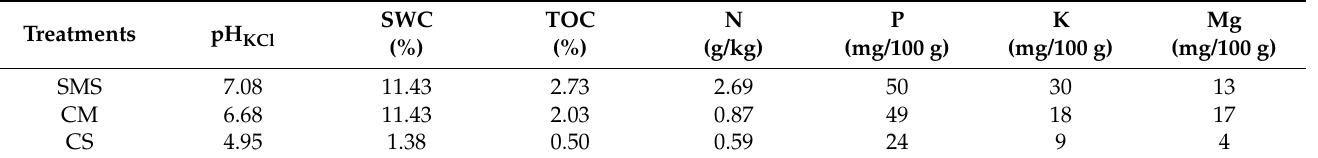
Table 1. Properties of soil under different treatments. Explanations: SMS—spent mushroom substrate, CM—chicken manure, CS—control soil, SWC—soil water content (moisture), TOC—total organic carbon.